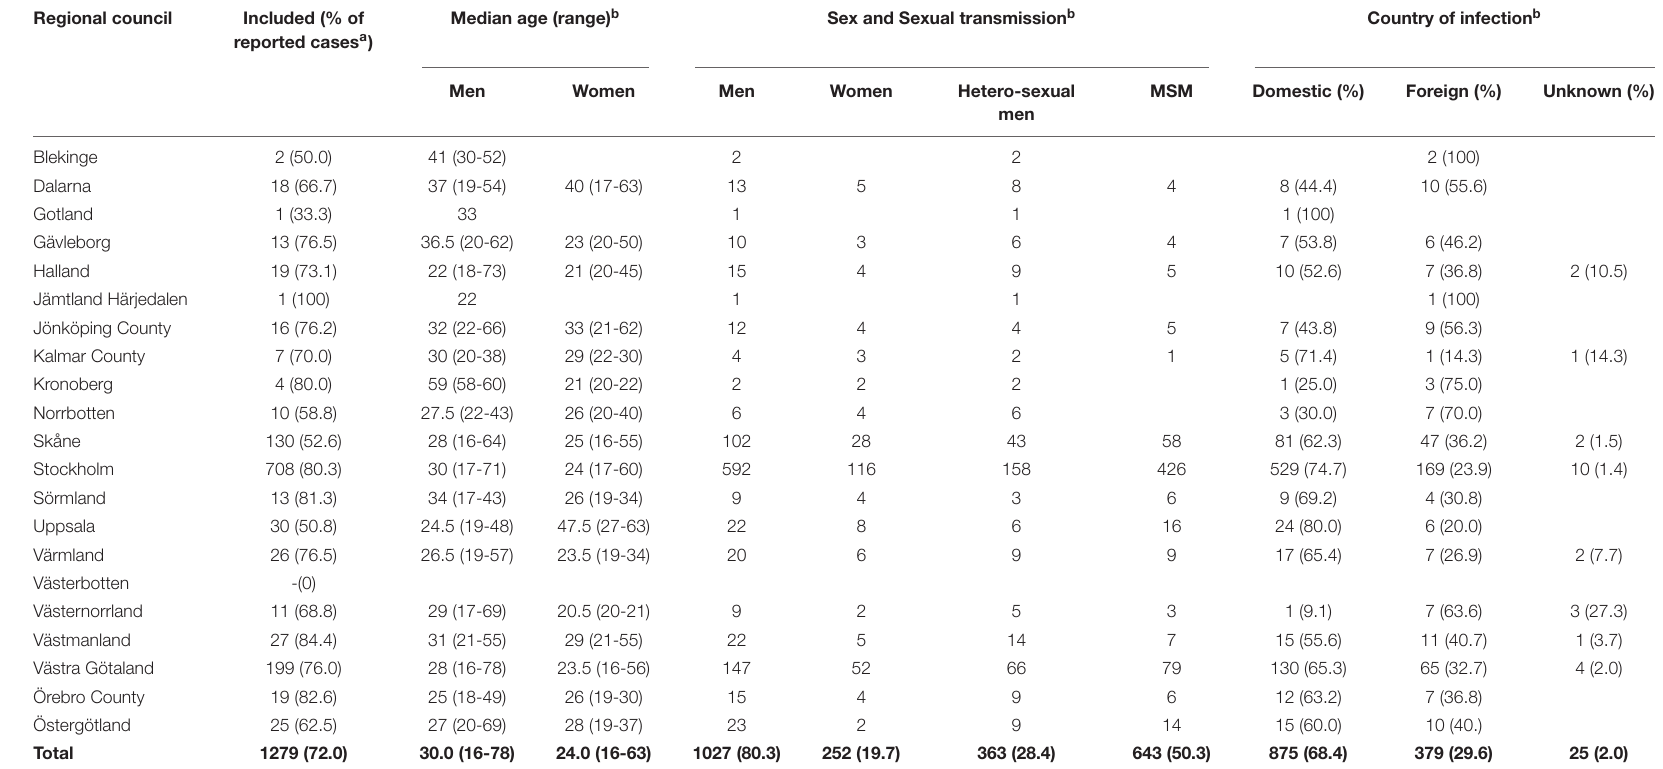
TABLE 1 | Demographics and epidemiological characteristics of included gonorrhea patients in Sweden in 2016 by regional council. Regional